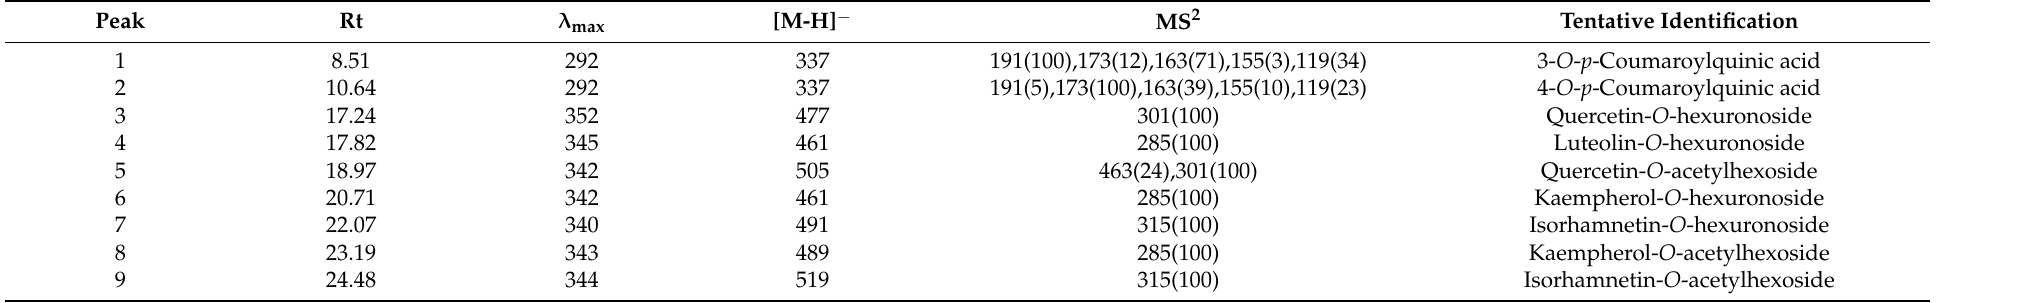
Table 5. Retention time (Rt), wavelength of the maximum absorption ( λ max ), deprotonated ion ([M-H] − ), main mass fragments (MS 2 ), and tentative identification of the phenolic compounds found in the hydroethanolic and aqueous extracts of C. spinosum samples.